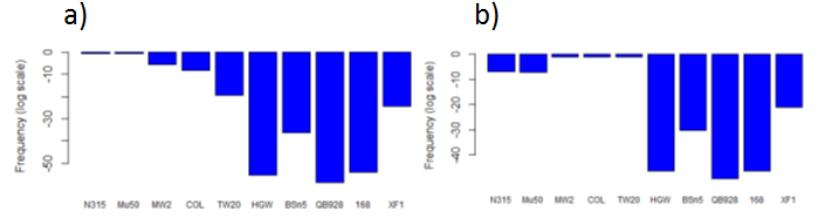
Fig. 7: Distribution of tokens from MRSA and B. subtilis strains in a) Component 1 and b) Component 3. Strains N315, Mu50, MW2, COL and TW20 are MRSA strains, while the remainder are B.